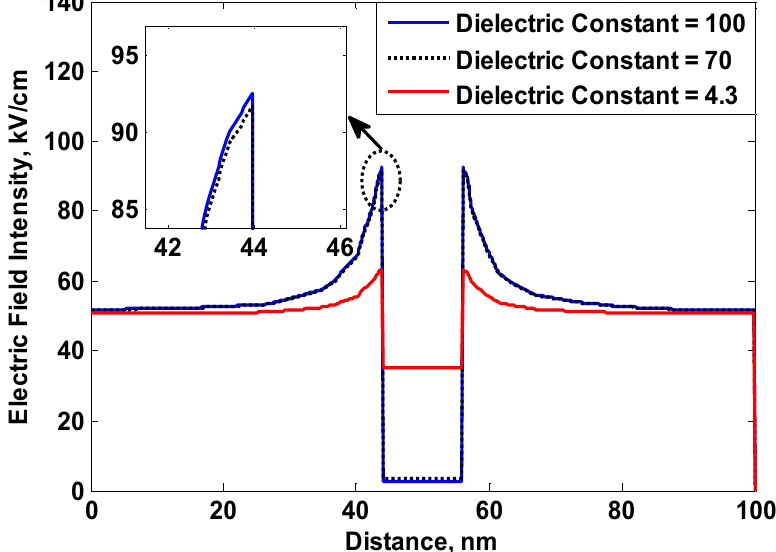
Figure 15. Electric field distribution with no surface charges on nanoparticles having different dielectric constants.